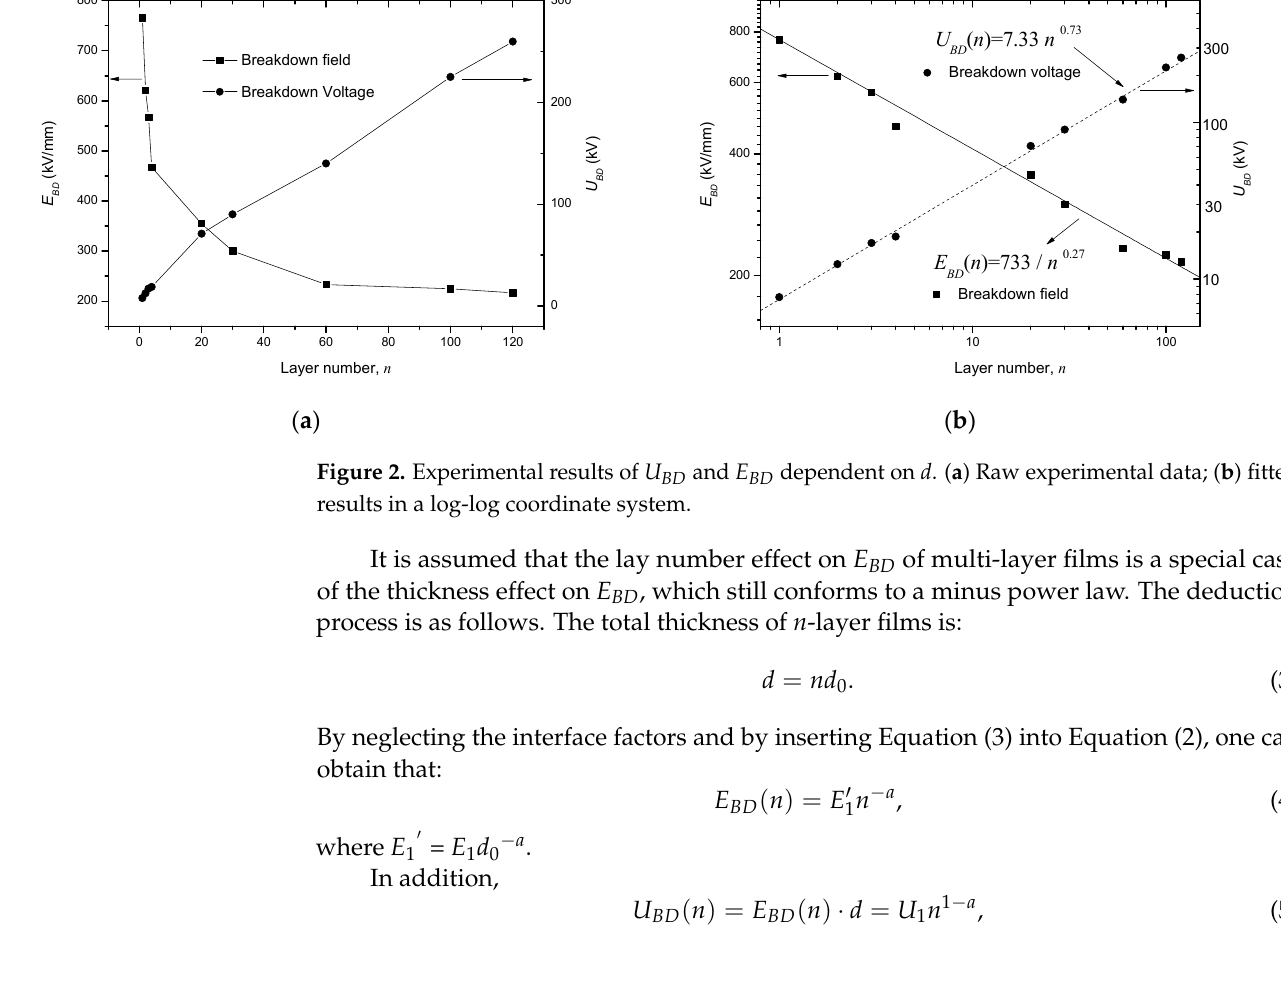
( b ) Figure 3. Re-plot and fit different groups of E BD - n data in log-log coordinate systems. ( a ) E BD - n data with moderate tendency; ( b ) E BD - n data with sharp and slow tendencies. Table 2 lists the value of the power exponent, a , as well as the test information of these five groups of data, together with the data in this paper. From this table, it is seen that a ranges from 0.072 to 0.56 for different polymer films under different test conditions. Figure 4 shows the value of a in a wide layer number range. From this figure, it is seen that the minus power relation of these six groups of data can be divided into three types according to the value of a :